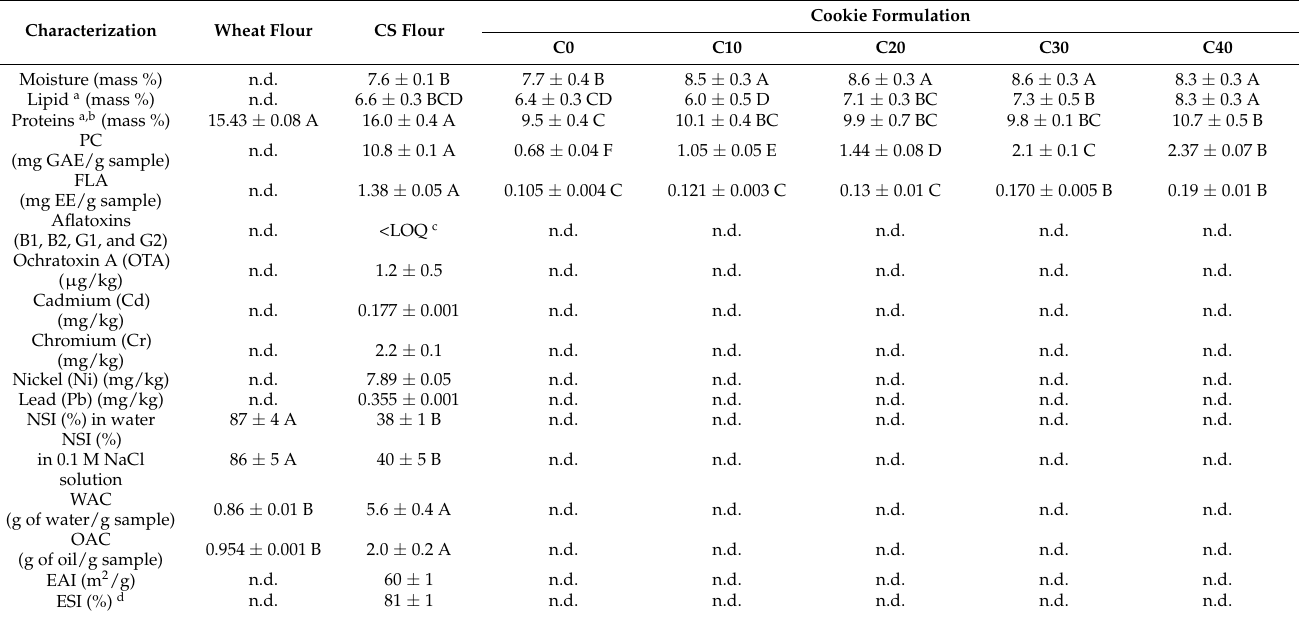
Table 2. Characterization of wheat flour, CS flour, and the cookies